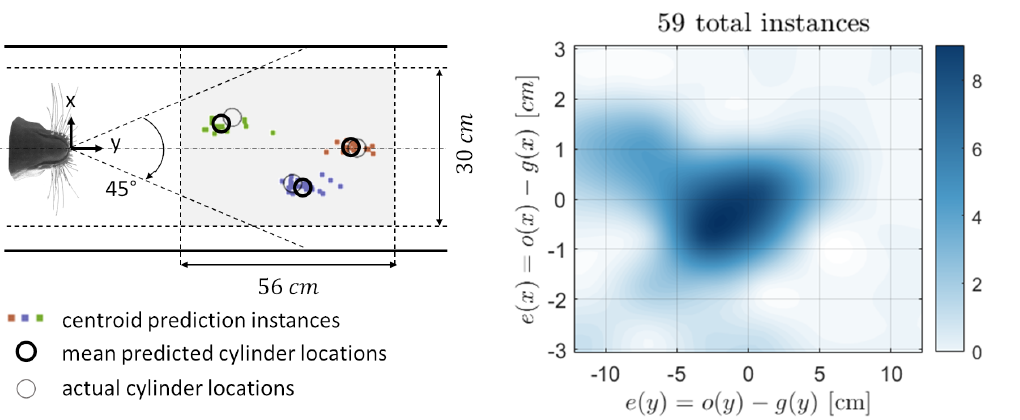
Figure 8. Results of the NNs predictions of ( x , y ) coordinates of three different cylinder locations using the input samples of the test dataset. For a total of 59 input samples and three different locations of the cylinder, the prediction instances of each location and their mean are represented by different colours ( left ). The two-dimensional (2D) error histogram (algorithm available here [47]) is presented as a colour-contour plot with a total number of 25 bins and a biharmonic interpolant fitting function ( right